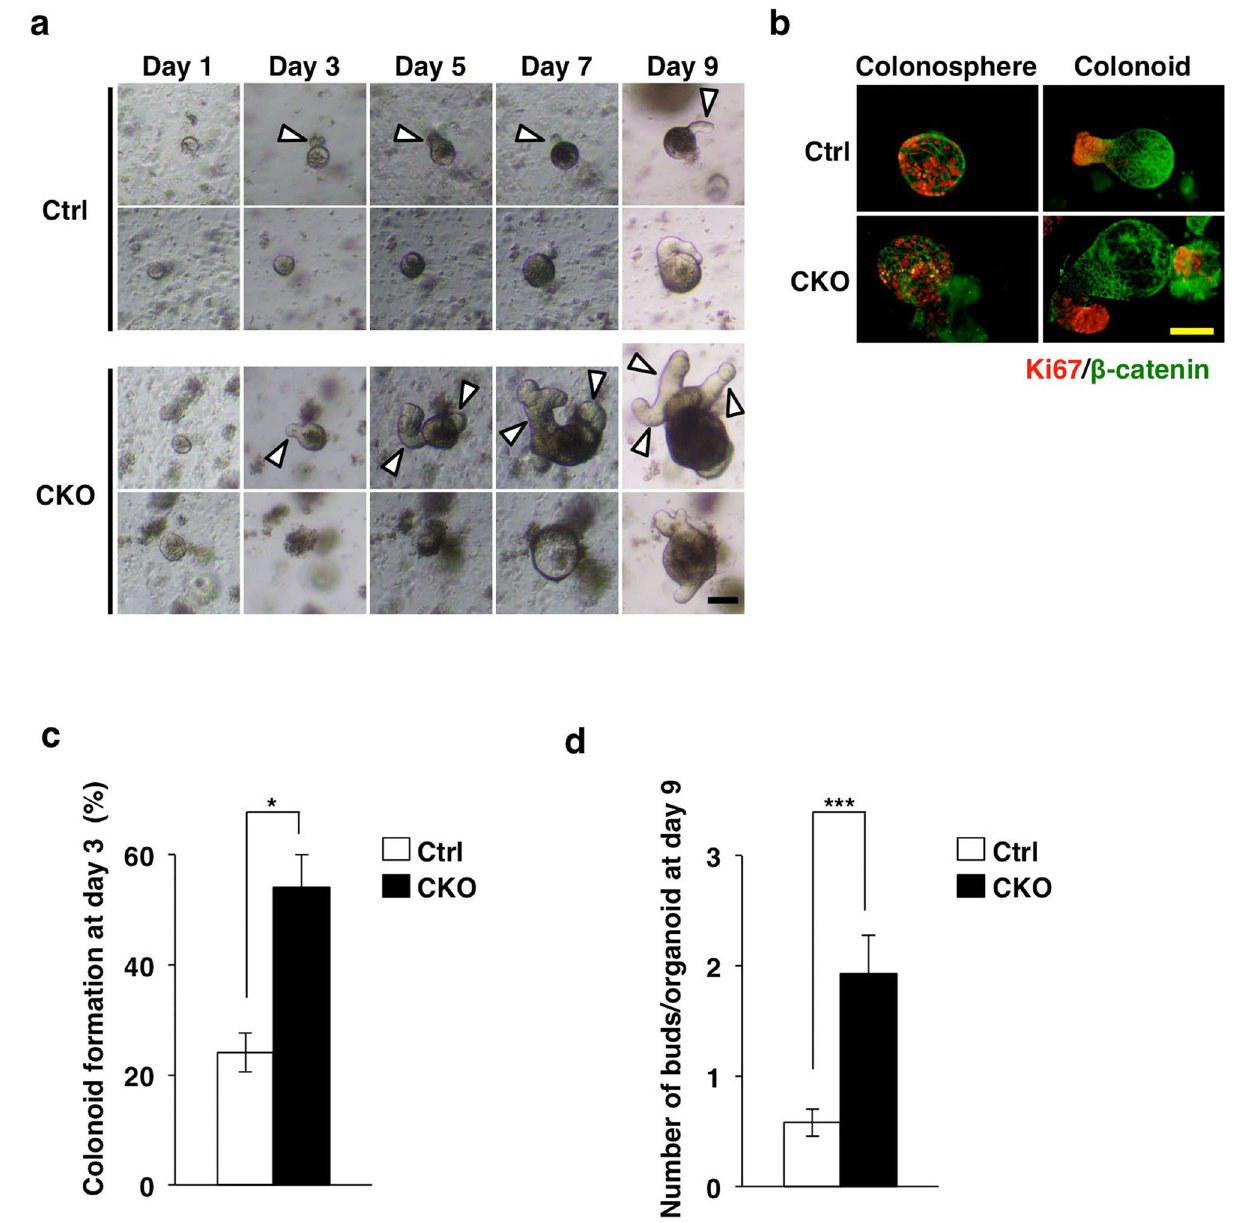
Figure 4. Promotion of the development of colonic organoids by Tsc2 ablation. ( a ) Representative phase- contrast images of colonic organoids derived from the colon of 9- to 13-week-old control or Tsc2 CKO mice at 1, 3, 5, 7, and 9 days after cell plating. The white arrowheads indicate cryptlike buds. Scale bar, 100 μm. ( b ) Immunofluorescence analysis of Ki67 (red) and β-catenin (green) in colonic organoids cultured for 7 days as in (a) . Scale bar, 100 μm. ( c ) The number of colonoids was determined as a percentage of colonic organoids at 3 days after cell plating as in (a) . Data are means ± s.e. for a total of 105 (control) or 119 (Tsc2 CKO) organoids in three independent experiments. * P < 0.05 (Student’s t test). ( d ) The number of buds per colonic organoid was determined at 9 days after cell plating. Data are means ± s.e. for a total of 38 (control) or 28 (Tsc2 CKO) organoids in three independent experiments. *** P < 0.001 (Student’s t